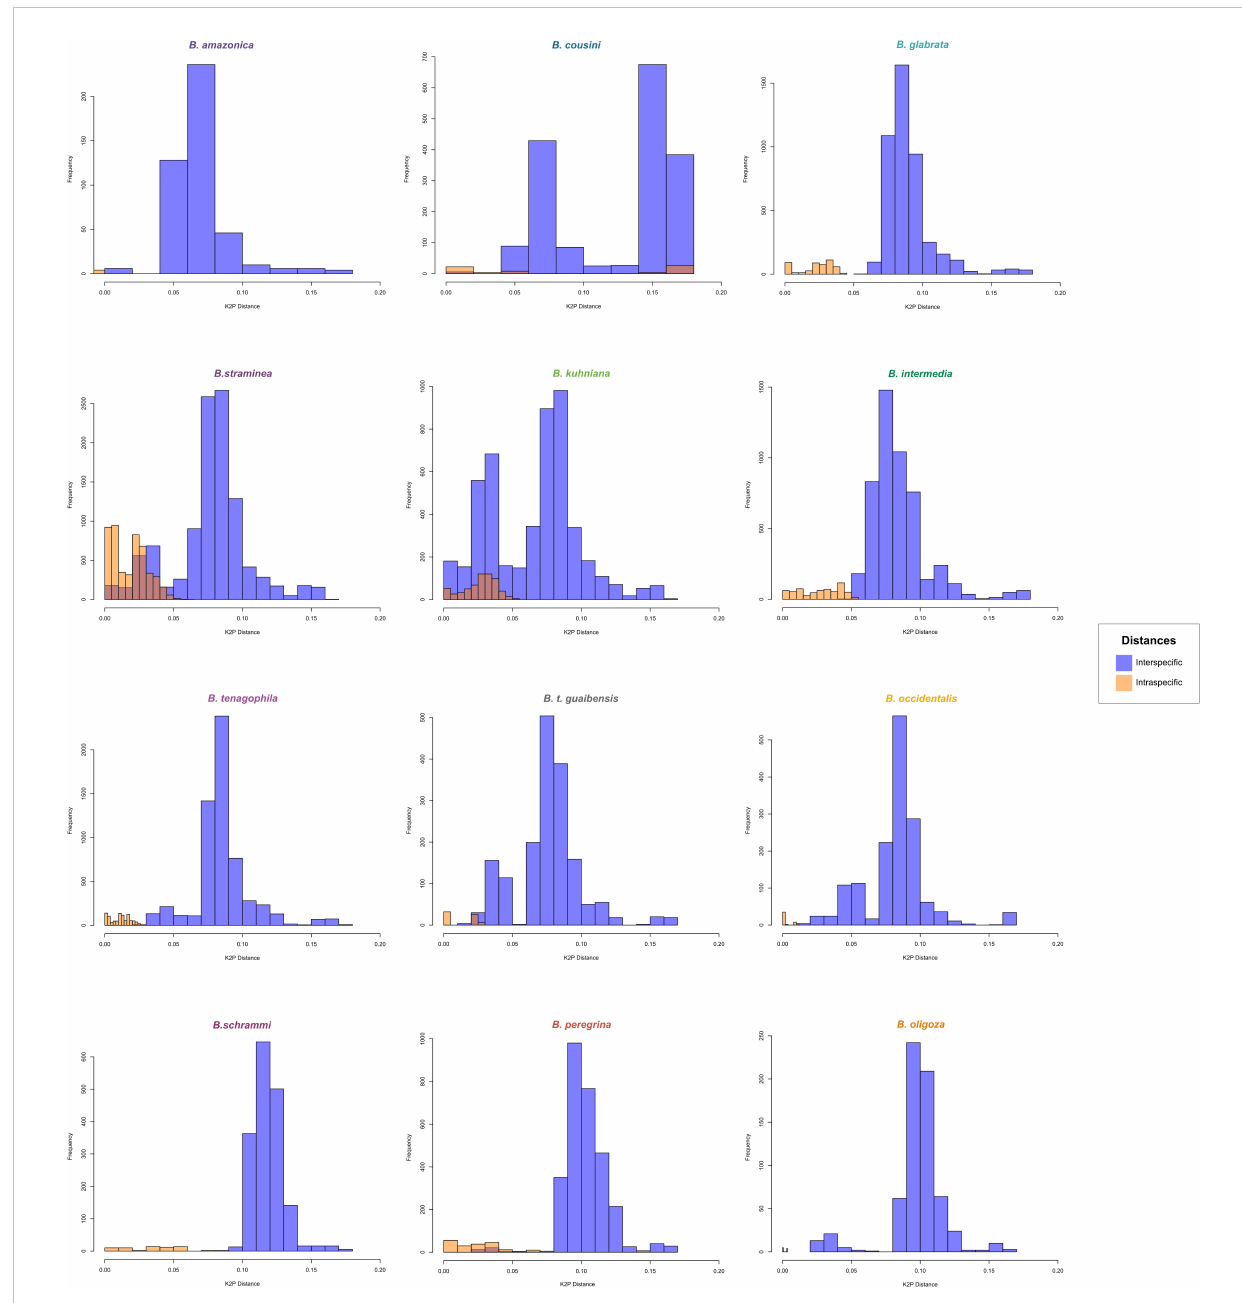
FIGURE 5 Frequency distribution of intraspeci fi c and interspeci fi c distances of Biomphalaria partial coi sequences according to species. Histogram of intraspeci fi c (orange) and interspeci fi c (blue) distances based on the Biomphalaria coi partial sequences. Pairwise distances were expressed as percentage dissimilarity for each species: B. amazonica , B. cousini , B. glabrata , B. straminea , B. kuhniana , B. intermedia , B. tenagophila , B. t. guaibensis , B. occidentalis , B. schrammi , B. peregrina , and B. oligoza